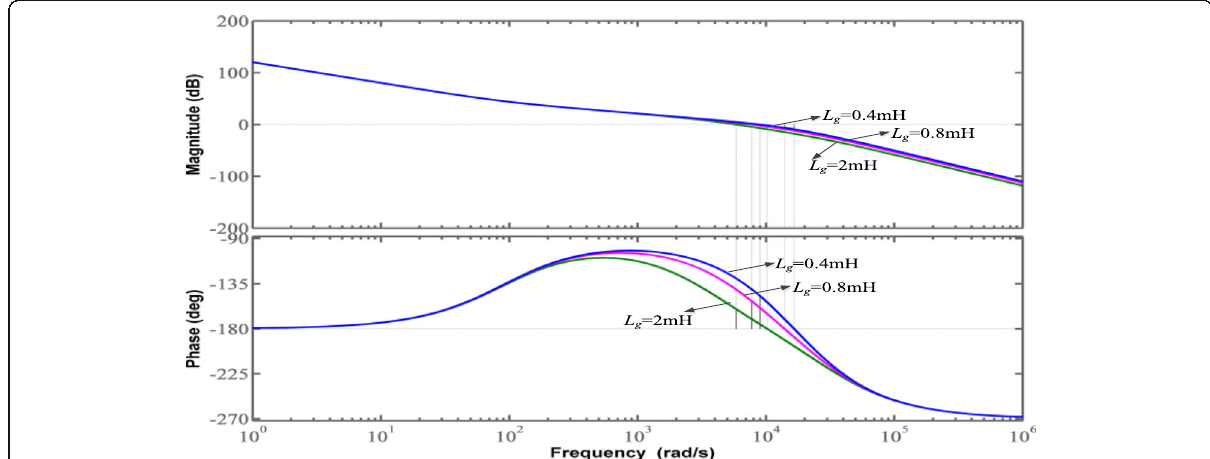
Fig. 9 The grid-connected current open-loop Bode diagram when the grid impedance